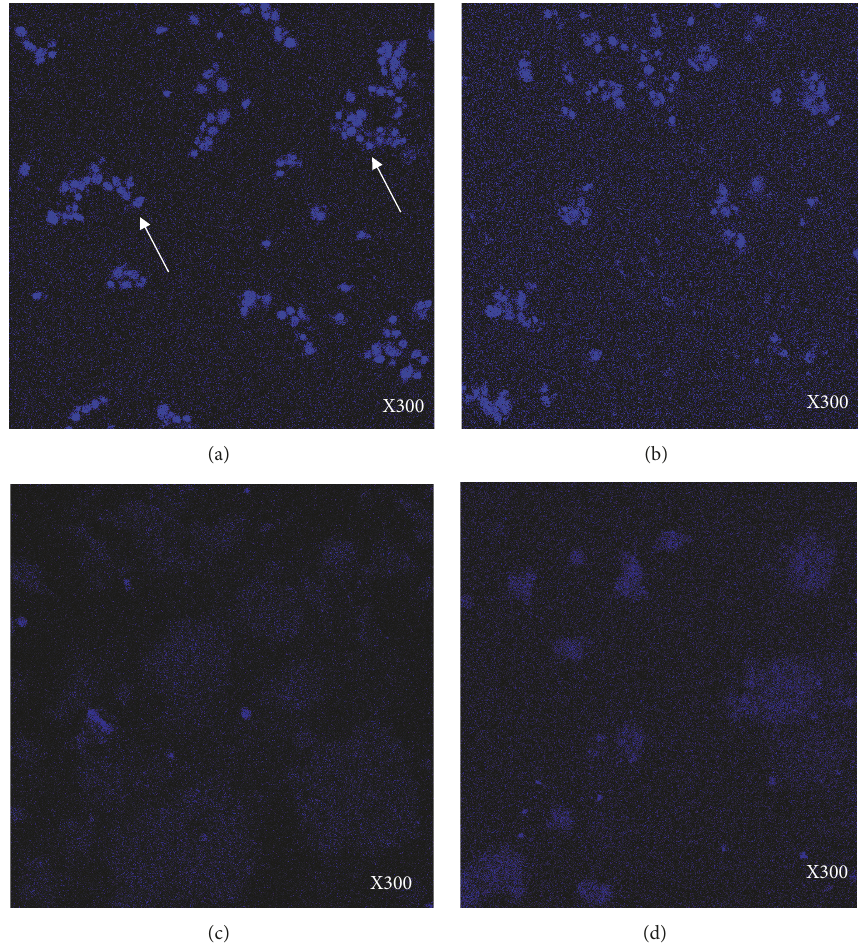
Figure 5: Scanning Microscopy through DAPI stained cells: the MCF-7 cells were stained with DAPI after 48hrs of treatments. Figure (a) is control, live cells stained with blue (arrows); (b) treated with FMSP-nanoparticles (12.5 𝜇 g/mL) +clove extracts (100 𝜇 g/mL); (c) treated with FMSP-nanoparticles (50 𝜇 g/mL) +clove extracts (100 𝜇 g/mL); (d) treated with FMSP-nanoparticles (100 𝜇 g/mL) +clove extracts (100 𝜇 g/mL); 300 x